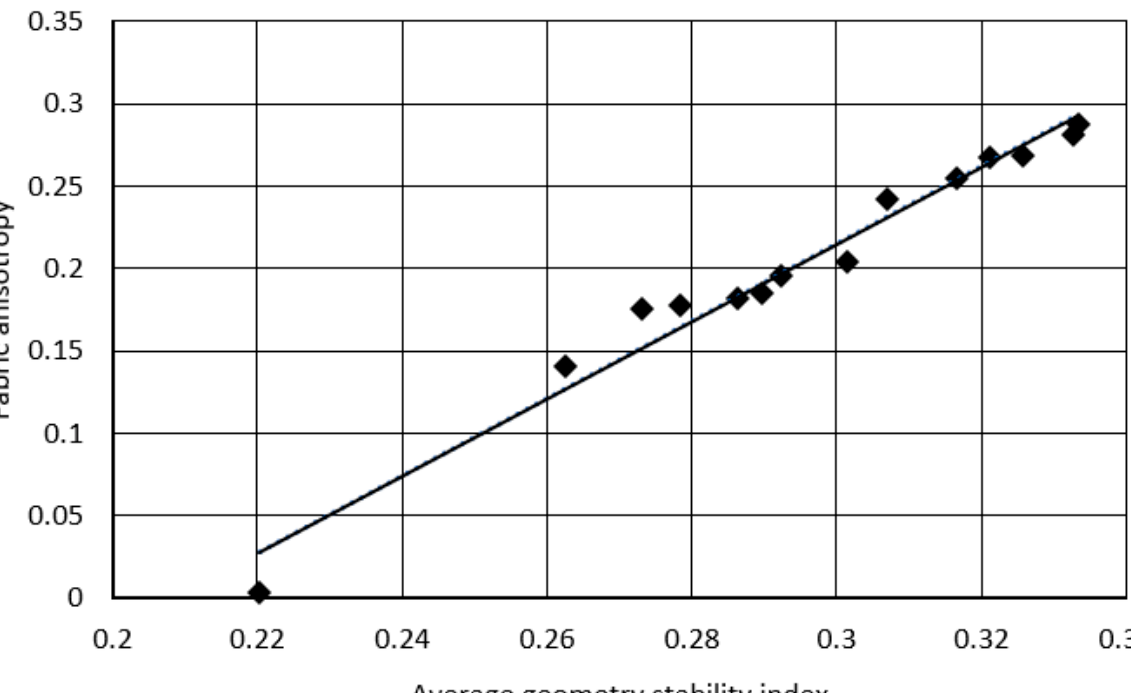
Figure 17. Average geometry stability index with fabric anisotropy.